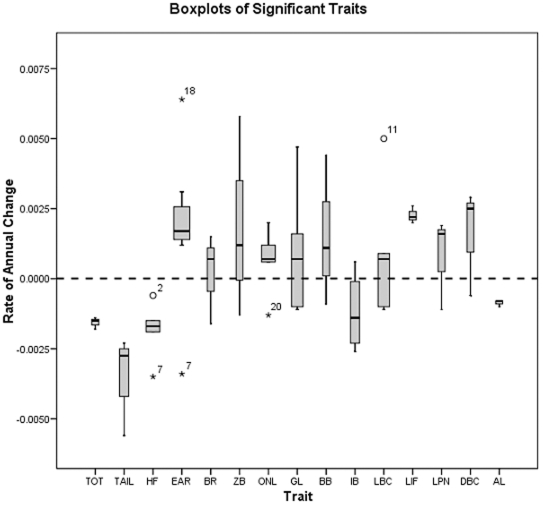
Box plots of rates of significant annual changes.Includes all cases for which changes were significant at p<0.05 after sequential Bonferroni correction. The length of the box is the interquartile range (IQR) computed from Tukey's hinges. Values more than three IQR's from the end of a box are extremes and are labeled with asterisks. Values more than 1.5 IQR's but less than 3 IQR's from the end of the box are outliers and are labeled with circles. Each extreme and outlier is labeled by case number as in Table 1.